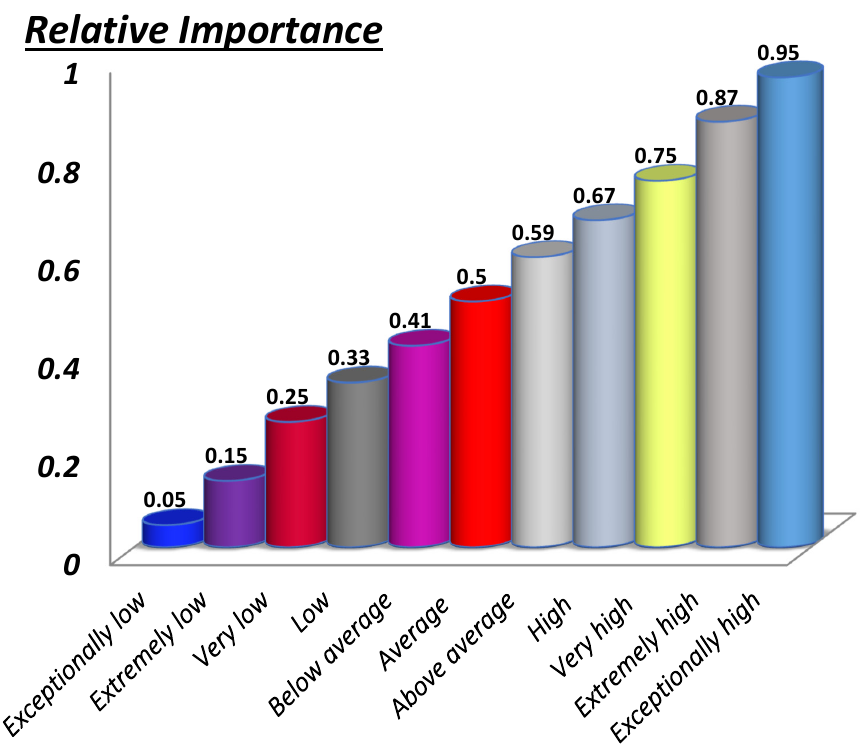
Figure 2. The 11-point fuzzy logic color scale.